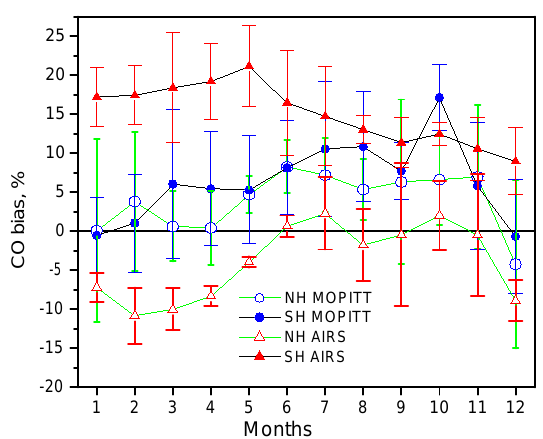
Fig. 3. Seasonal dependence of CO TC bias for two satellite sounders in both hemispheres. Monthly averaged deviations of CO TC measured by satellite sounders from those measured by ground- based